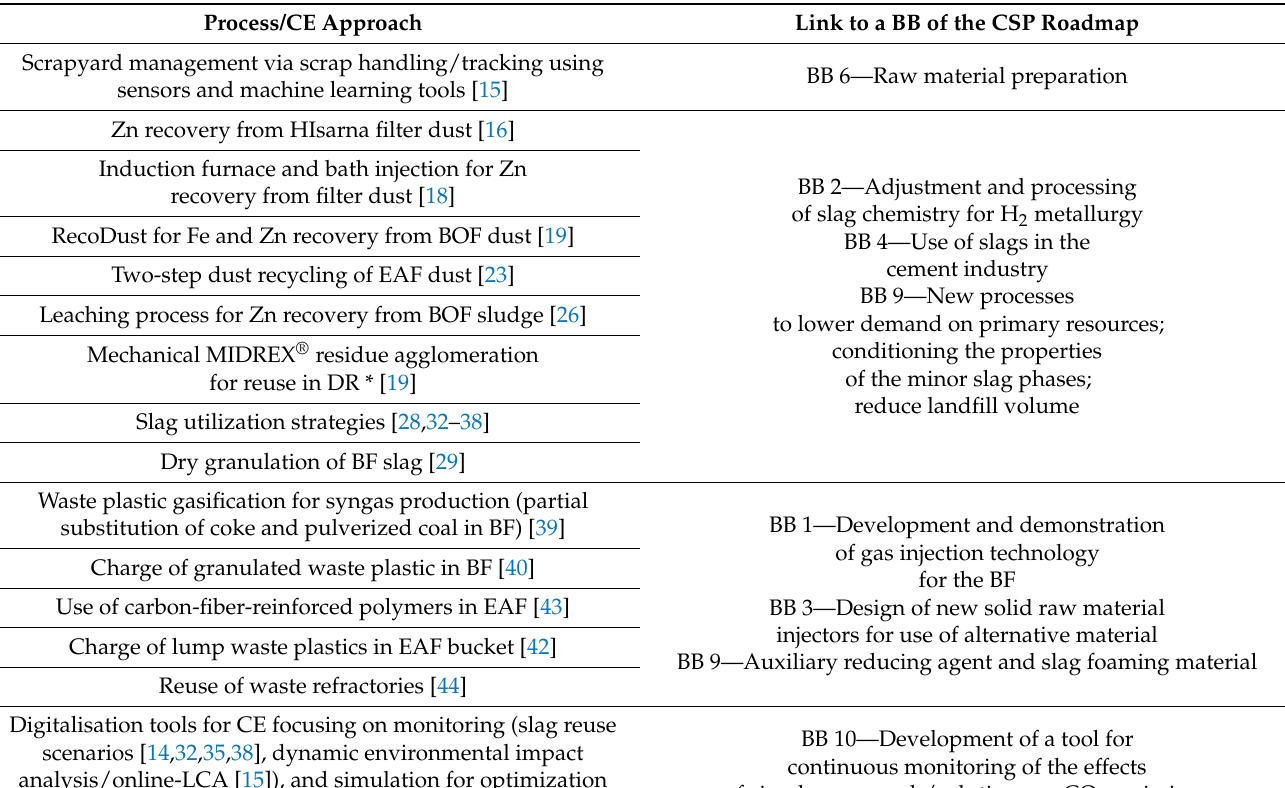
Table 3. Link of currently ongoing European CE research initiatives to the Clean Steel Partnership. Process/CE Approach Link to a BB of the CSP